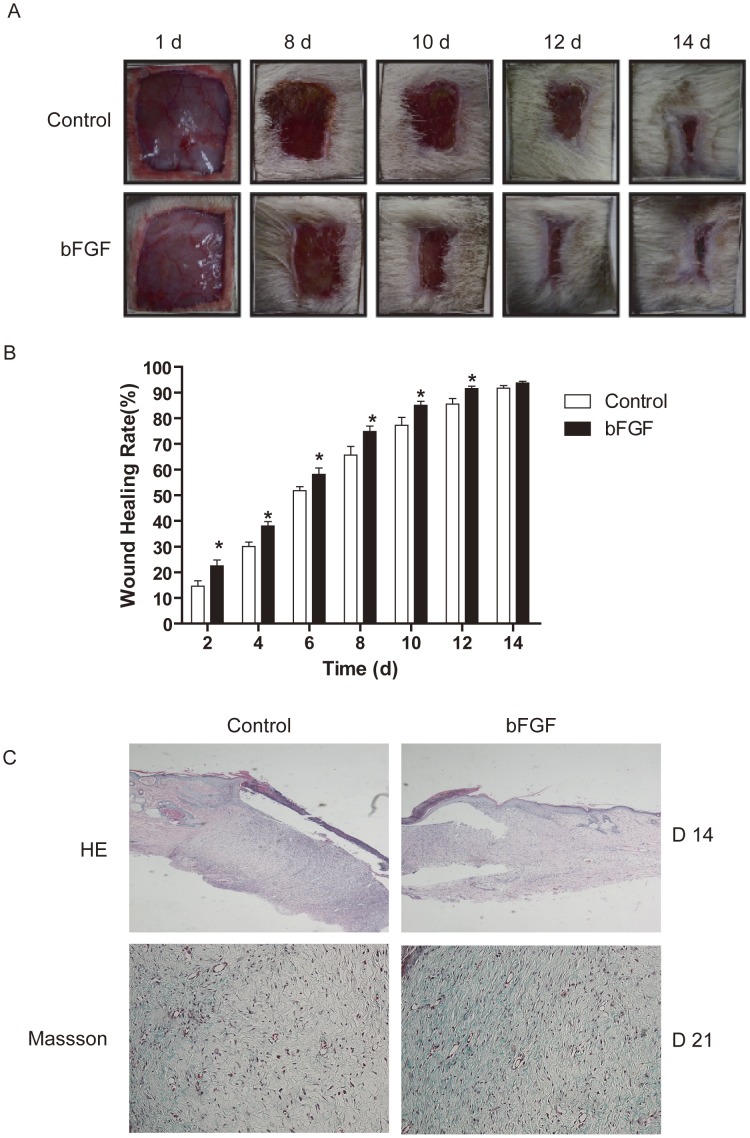
Wound closure and histopathological characteristics of bFGF treated wound healing in rat.(A) Representative photographs of full-thickness skin wounds at various time points after treatment with or without 1 µg/ml bFGF. (B) The wound healing rates of bFGF. *P<0.05 compared to control group, n = 8. (C) Histopathological observation and masson staining of collagen in wound healing at day 14 post-wounding (×200).